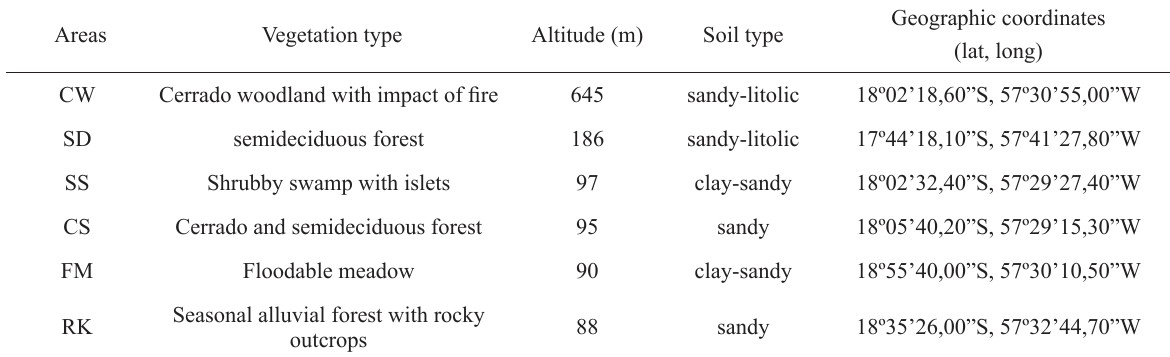
Vegetation types, soil, altitude data and geographic coordinates of the six studied areas along the Paraguay River, Pantanal, Brazil. Area 1: CW - Serra do Amolar; Area 2: SD - RPPN Acurizal; Area 3: SS - Lake Taquaral; Area 4: CS - RPPN Eliezer Batista; Area 5: FM - Lake Mandioré; Area 6: RK - Lake